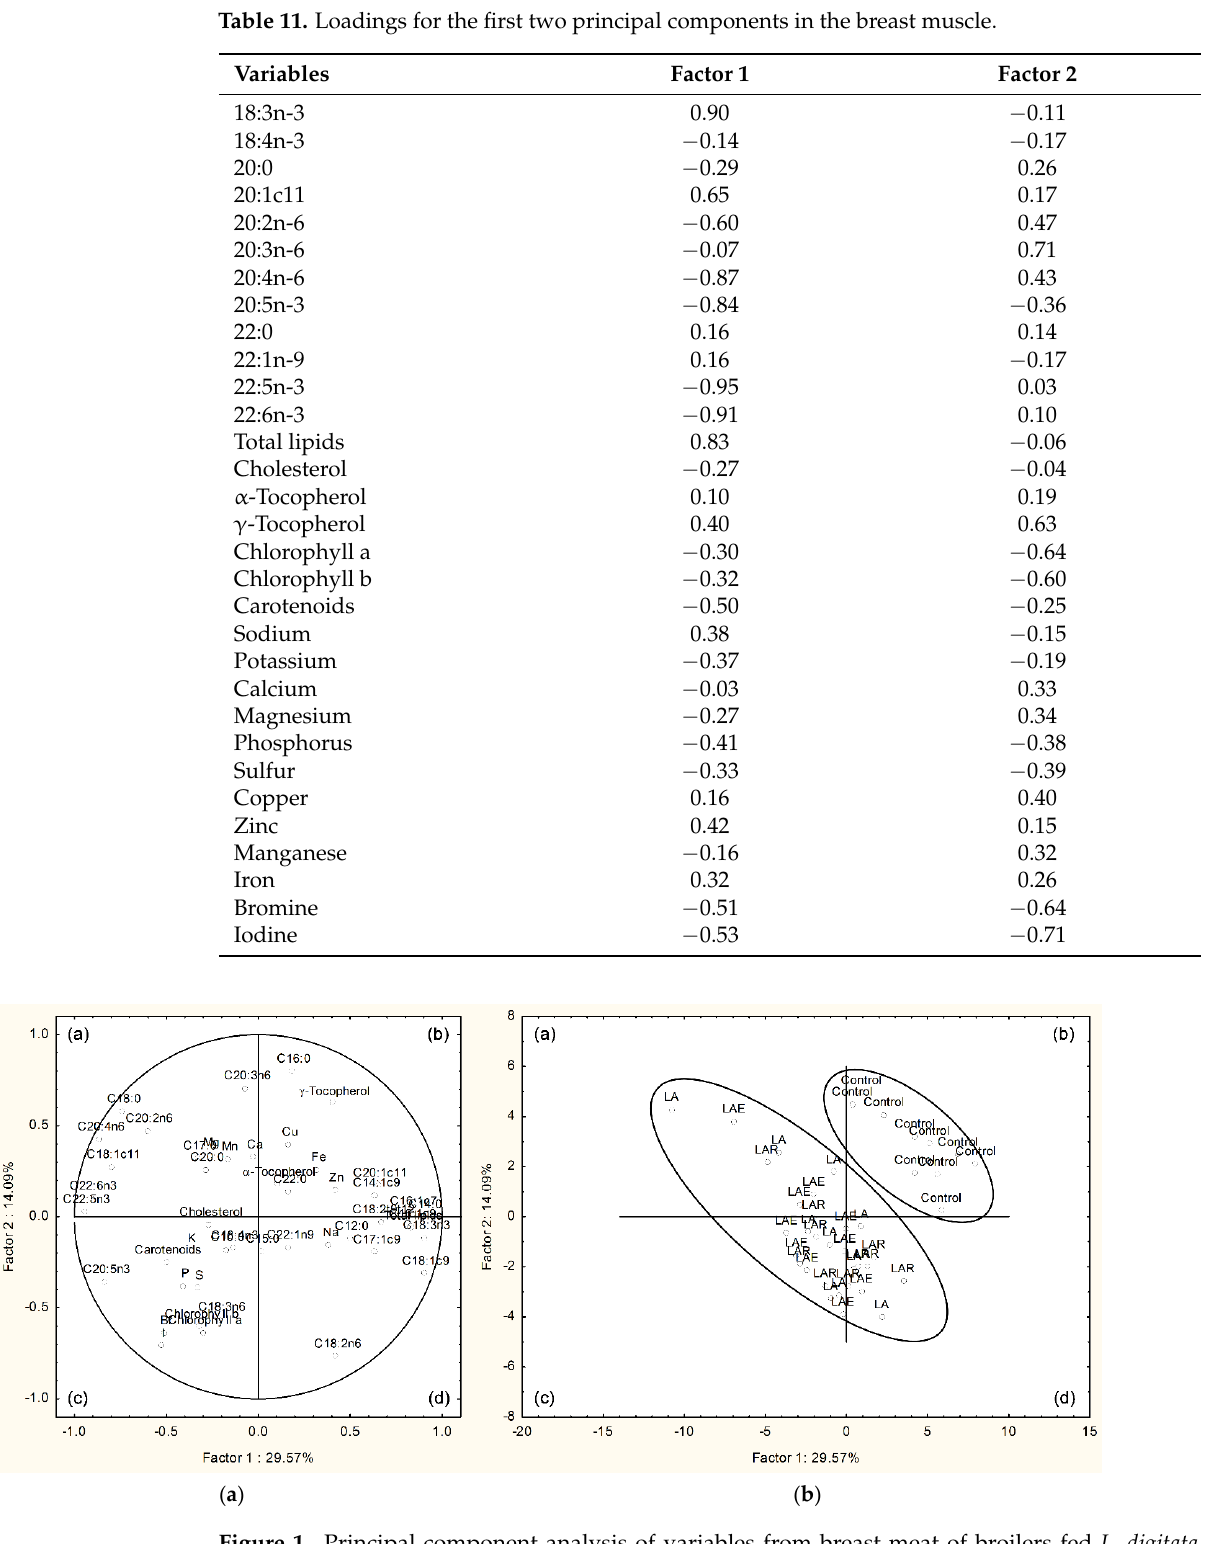
Figure 1. Principal component analysis of variables from breast meat of broilers fed L. digitata , individually or combined with exogenous CAZymes: ( a ) loading plot of the first and second principal components of pooled data; ( b ) component score vectors. Dietary treatments: control, corn–soybean basal diet; LA, basal diet plus 15% L. digitata ; LAR, basal diet plus 15% L. digitata + 0.005% Rovabio ® Excel AP; LAE, basal diet plus 15% L. digitata + 0.01% recombinant CAZyme; (a – d) represent the quadrants a, b, c, and d.